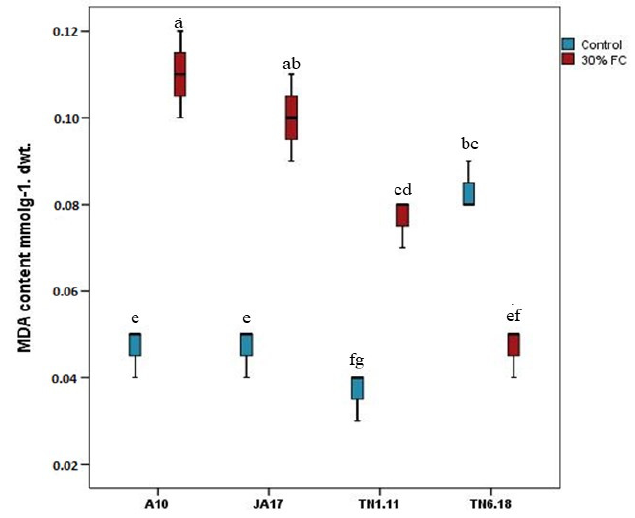
Figure 7. MDA content in M. truncatula studied lines under control treatment and 30% FC. Means